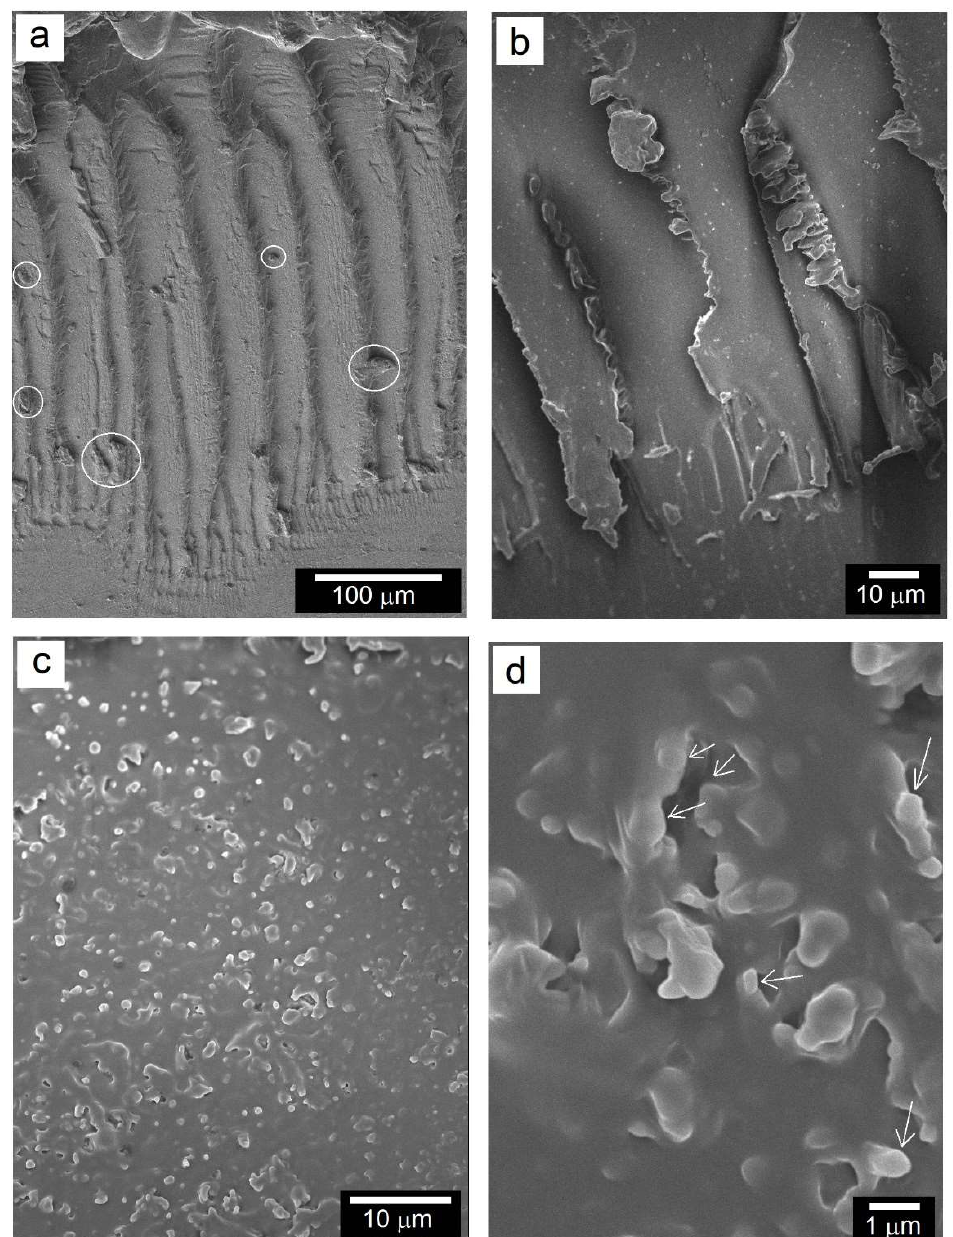
Figure 9. Low and high magnification views of different fracture features on PC sample cross-section after DOP exposure under high constant strain: ( a , b ) craze structure and its termination and/or branching, and ( c , d ) polymer dissolution leading to crater formation. The circles and arrows indicate craze branching and filler particle detachment, respectively.